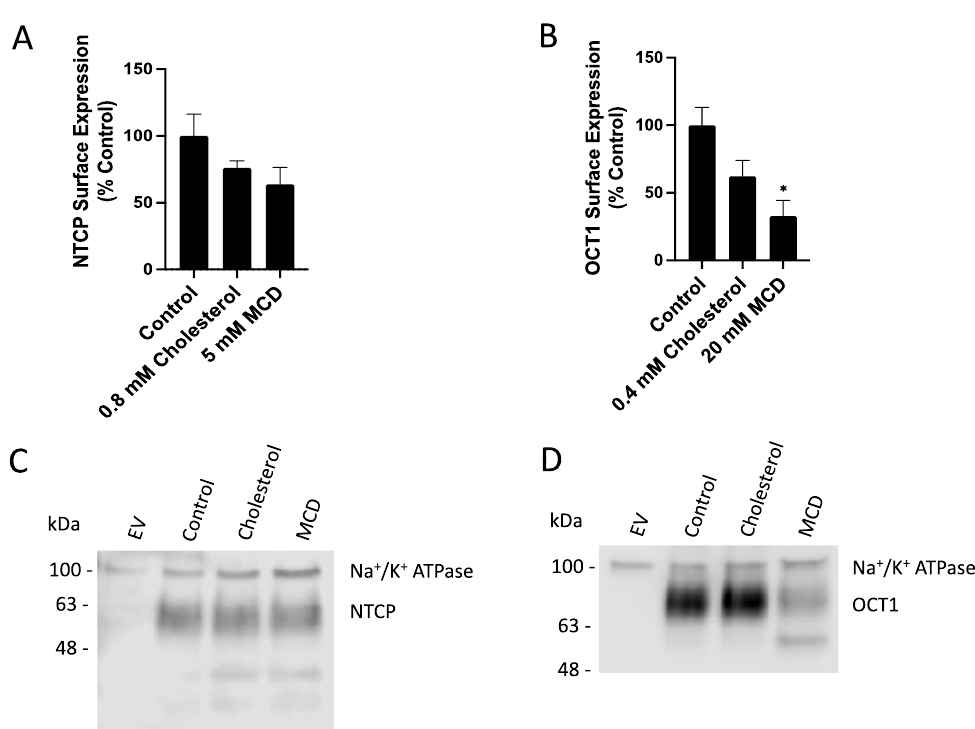
Figure 4. Surface expression of transporters after treatment with cholesterol or MCD. Quantification of plasma membrane expression for HEK293 expressing NTCP ( A ) or OCT1 ( B ). Cells were pretreated for 30 min with either Opti-MEM (control), cholesterol, or MCD. Representative western blots for NTCP ( C ) and OCT1 ( D ) surface expression are shown. Results were calculated as percent of control and reported as mean ± SEM of three independent experiments; an asterisk indicates a p < 0.05 compared to the control group.